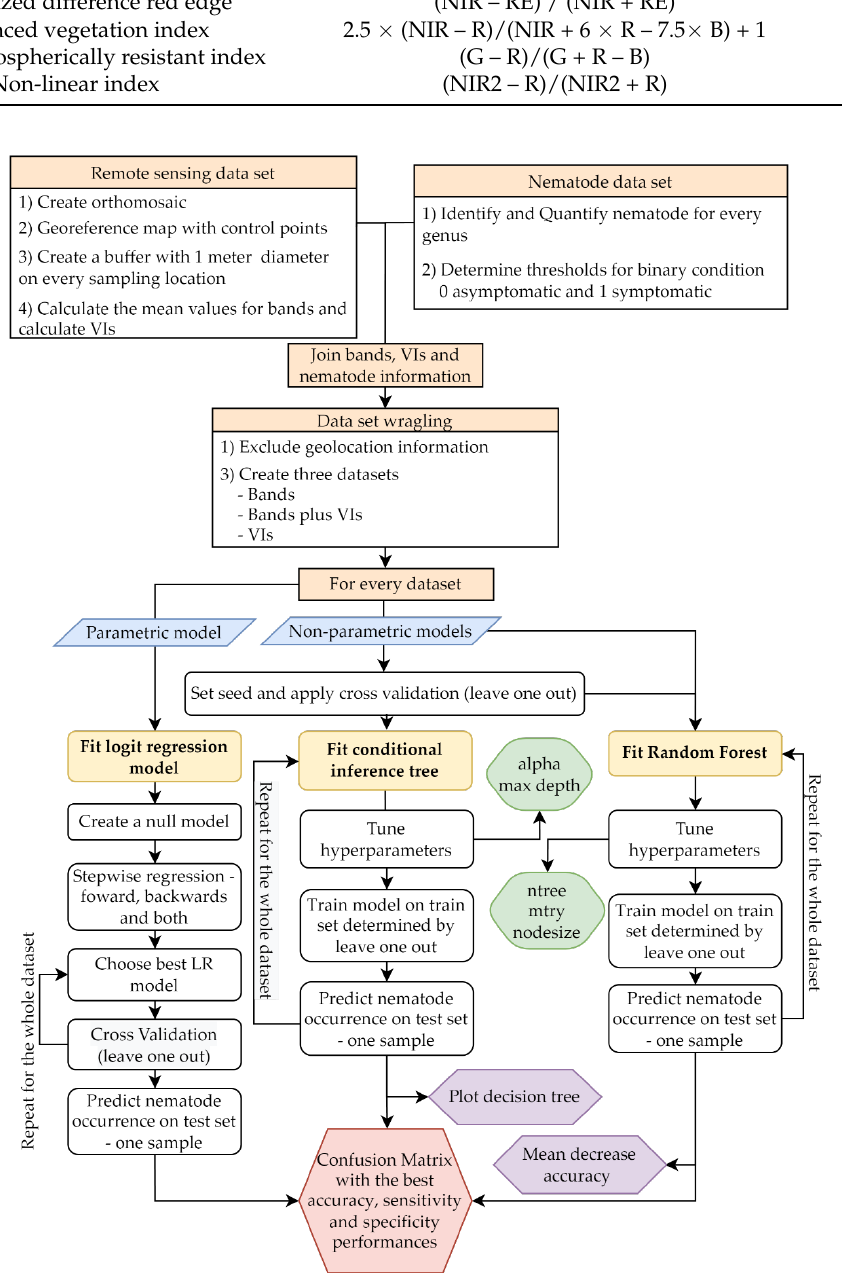
Figure 2. Data set generation and workflow of the tested models. The rectangle shapes represent the datasets, the parallelogram shapes the model type, the rounded rectangle the main processes, the rounded hexagons the hyperparameters tuned, and the hexagons represent the overall output of the process. LR = logit regression, VIs = vegetation indices.